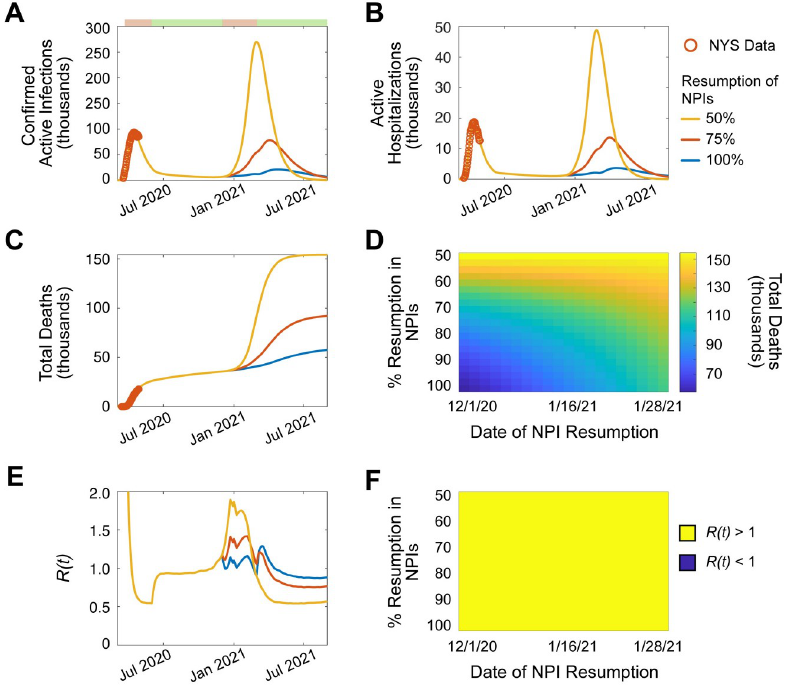
Fig 3. Recurrent outbreak of SARS-CoV-2 in NYS in early 2021. ( A-F ). Simulation of SARS-CoV-2 transmission dynamics in the presence of NPIs through September 1, 2021. Simulation assumes 50% NPI reduction on June 1, 2020. Periods of NPIs signified as in (A) top: pink, increased NPIs; green, relaxed NPIs. Orange circles, NYS SARS-CoV-2 data. Lines, simulated projection with resumption of NPIs on December 1, 2020 to Feb 28, 2021, and relaxation after March 1, 2020. A. Active confirmed infections. B. Active hospitalizations. C. Cumulative deaths. D. Heatmap displaying the effect of NPI magnitude and date of resumption on the number of cumulative deaths. E . R(t) . F. Categorical heatmap displaying the effect of NPI magnitude and date of resumption on R(t) > 1 (yellow, R(t) > 1; blue R(t) < 1). See also, S9